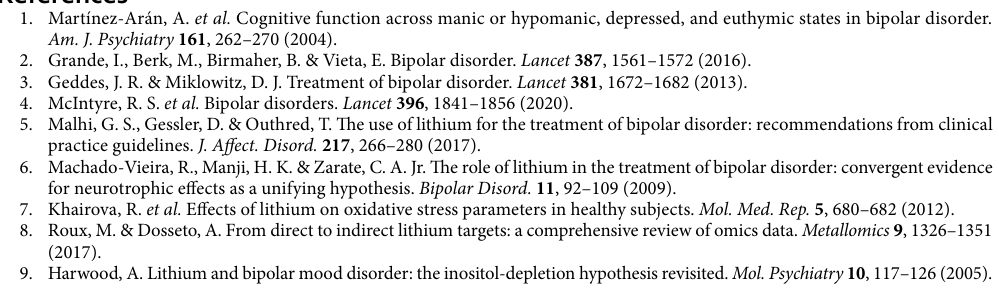
Figure 4. The dependence of the triplet yield of ratio, TY r , (green) on external magnetic field B for a 1 = 523.3 µ T, | a 2 | = 224.4 µ T, r = 1.0 × 10 k = 4.0 × 10 7 s − 1